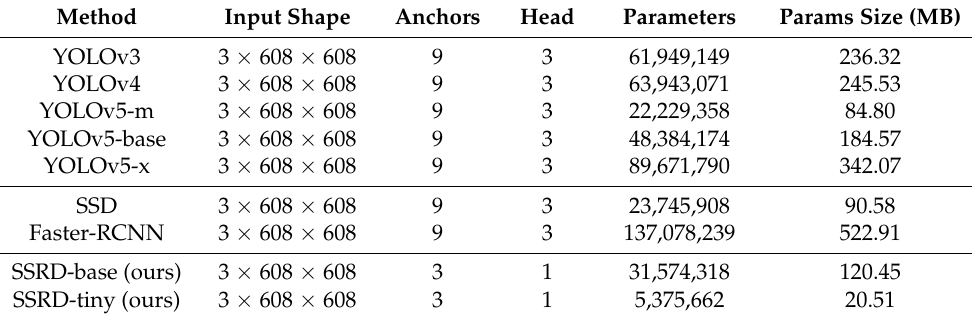
Table 3. Parameters of neural networks for target